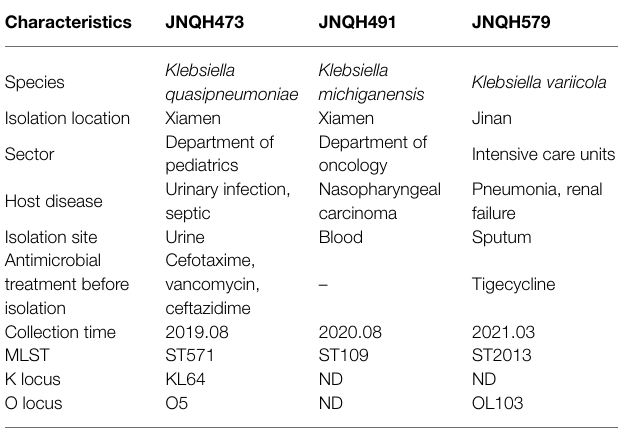
TABLE 1 | Overall strain features of JNQH473, JNQH491, and